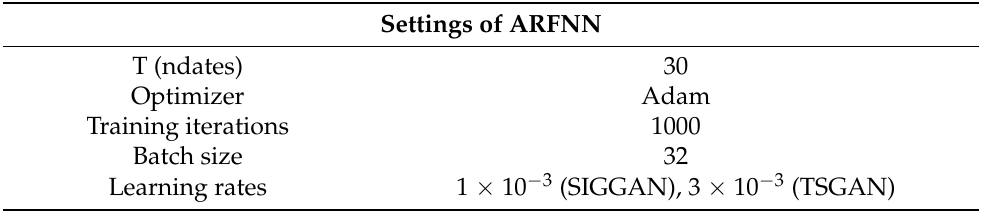
Table A3. Generator ARFNN